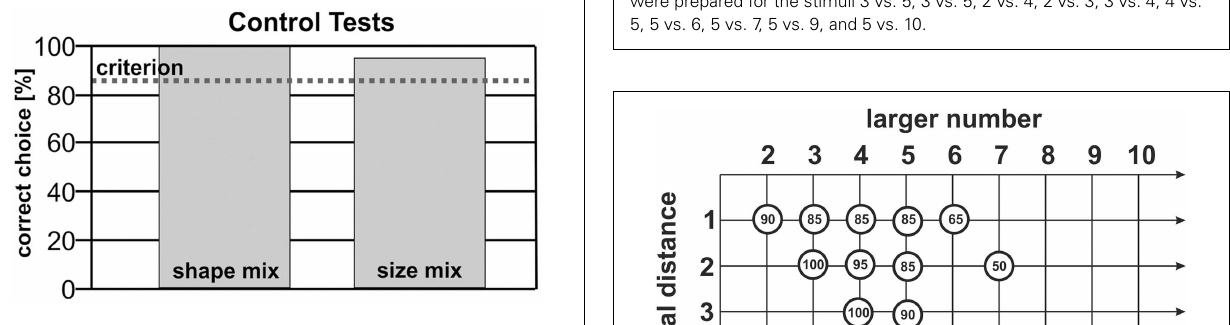
FIGURE 5 | Examples for the testing stimuli 2 vs. 5. Similar variations were prepared for the stimuli 3 vs. 5, 3 vs. 5, 2 vs. 4, 2 vs. 3, 3 vs. 4, 4 vs.